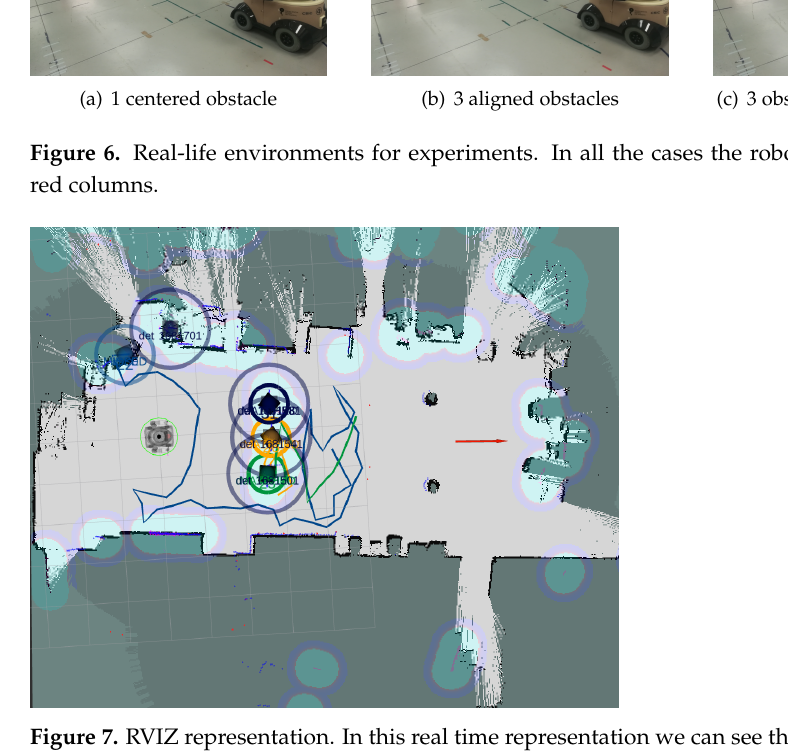
Figure 7. RVIZ representation. In this real time representation we can see the LiDAR observations (small red points), the tracks for moving obstacles or people (big circles) and the goal position (red